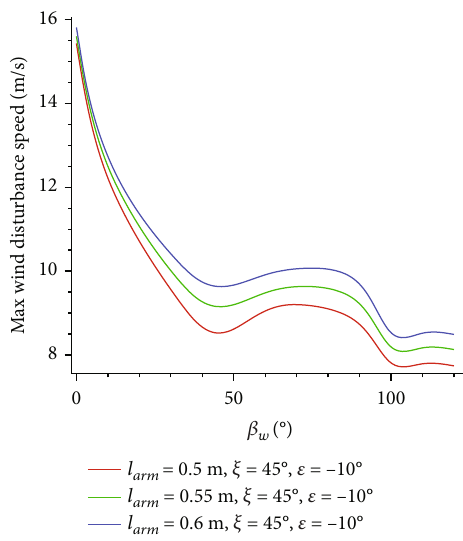
Figure 43: In fl uence of the l arm on the wind disturbance rejection performance as rotor inclined.